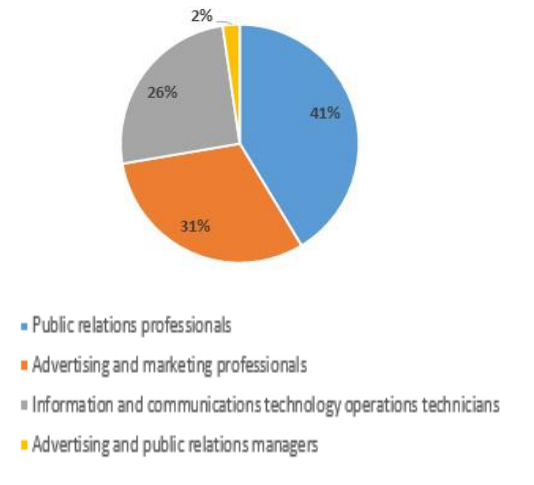
Figure 2: Occupation Profiles of Vacancies in area MARKETING AND COMMUNICATION